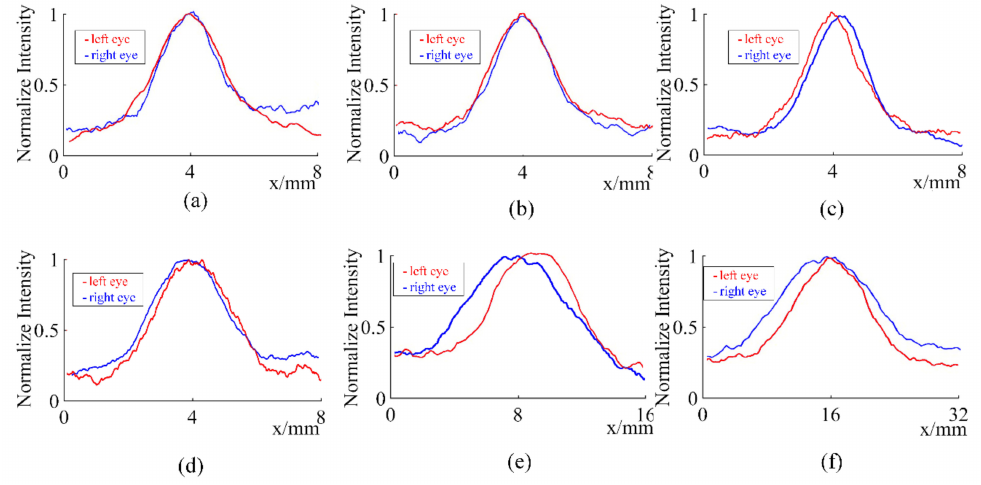
Figure 5. Experimental horizontal cross-section of spots intensity distributions ( a – f ) viewing angles of